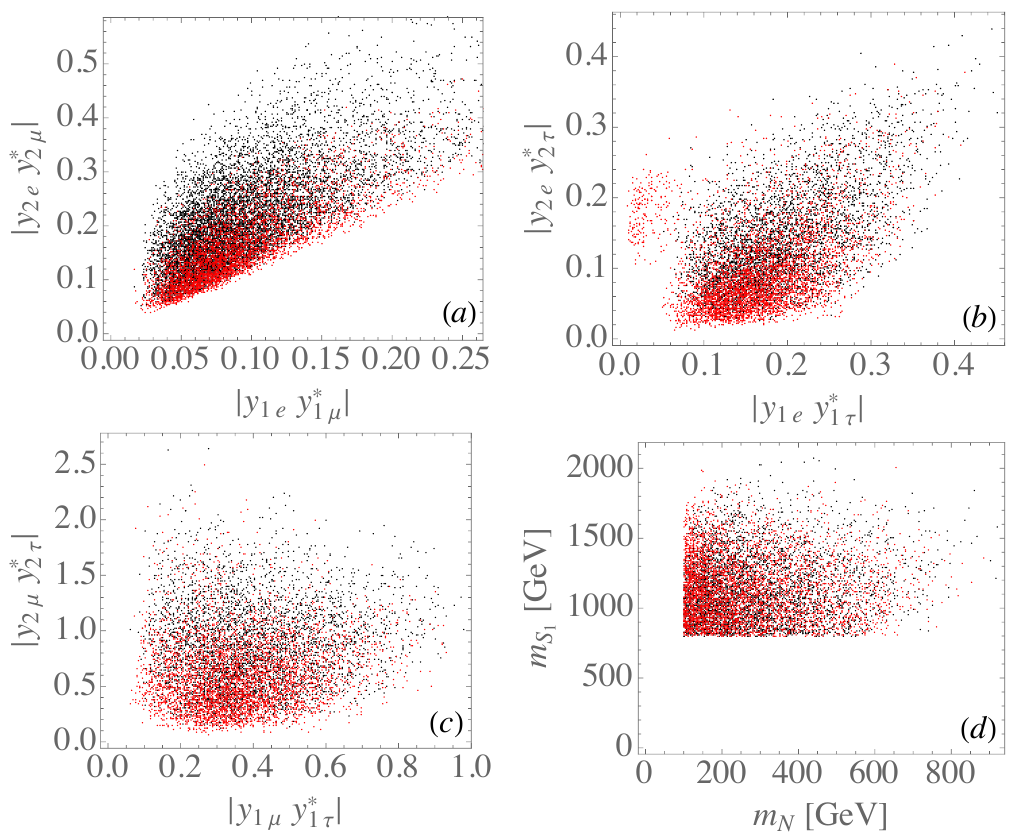
Figure 5 . (a)–(c) Constraints on various products of Yukawa couplings, and (d) allowed ranges of m . The black and red points denote the results of NO and IO, respectively. N,S 1 plots for BR ( µ → eγ ) as a function of | y (b), respectively, where the horizontal dashed line denotes the sensitivity of MEG II